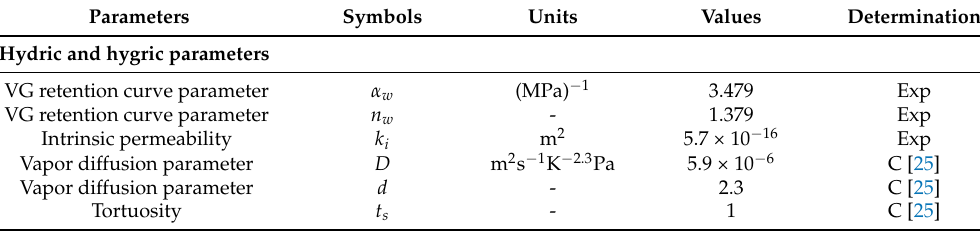
Table 3. Various material parameters used for THM coupled problem and the method of determina- tion of these parameters, where ‘Exp’ represents determined experimentally, ‘C’ represents that the classical or default value is chosen, and ‘L’ represents taken from the